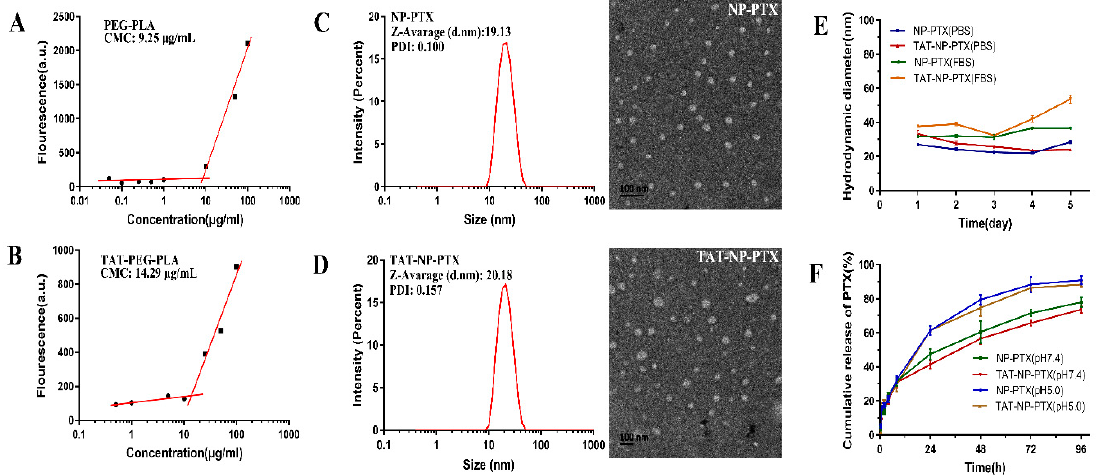
Figure 1. Characterization of related nanoparticles. The critical micelle concentration (CMC) value of polyethylene glycol-polylactic acid (PEG-PLA ) ( A ) and TAT-PEG-PLA ( B ); Nanoparticle size and transmission electron microscopy (TEM) morphology of NP-PTX ( C ) and TAT-NP-PTX ( D ); ( E ) The stability of NP-PTX and TAT-NP-PTX in fetal bovine serum (FBS) and phosphate-buffered saline (PBS), respectively; ( F ) In vitro PTX release behavior of NP-PTX and TAT-NP-PTX in PBS (pH 5.0 and 7.4) containing 0.1% of Tween-80.